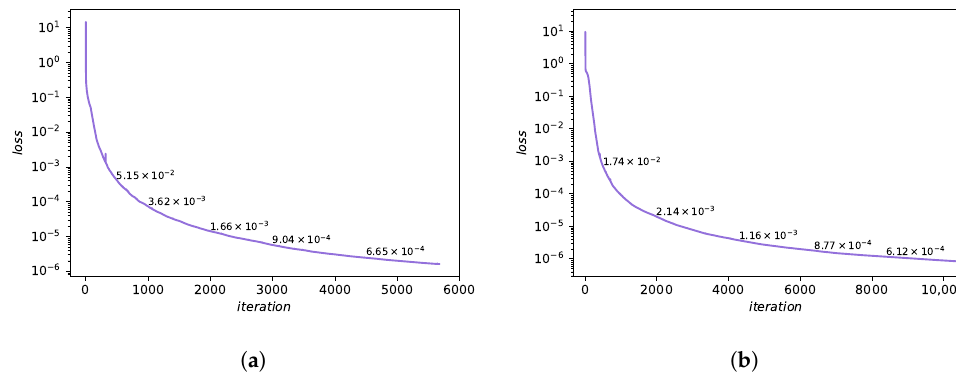
Figure 12. The Loss and error of Burgers and Allen–Cahn. ( a ) 1D Burgers. ( b ) Allen–Cahn.